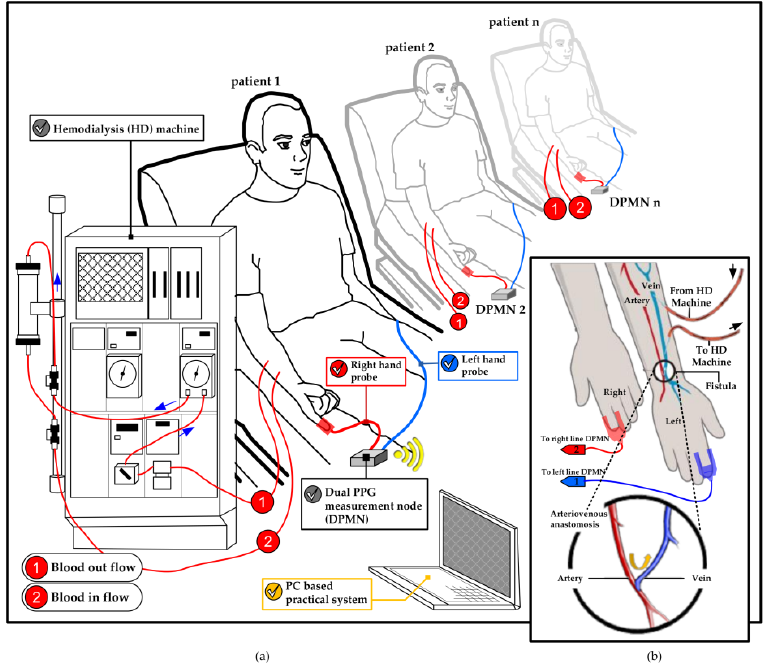
Figure 1. Dual optical PPG measurement technique: ( a ) PC Base practical PPG measurement with DPMN; ( b ) PPG probe placement and the fistula.